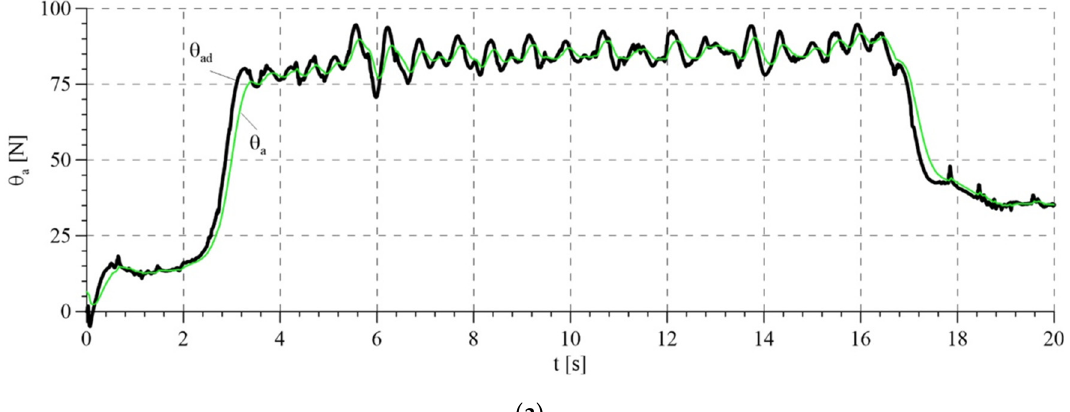
Figure 12. Rope reaction force realized with the use of the algorithm based on the mathematical model and the adaptive algorithm.